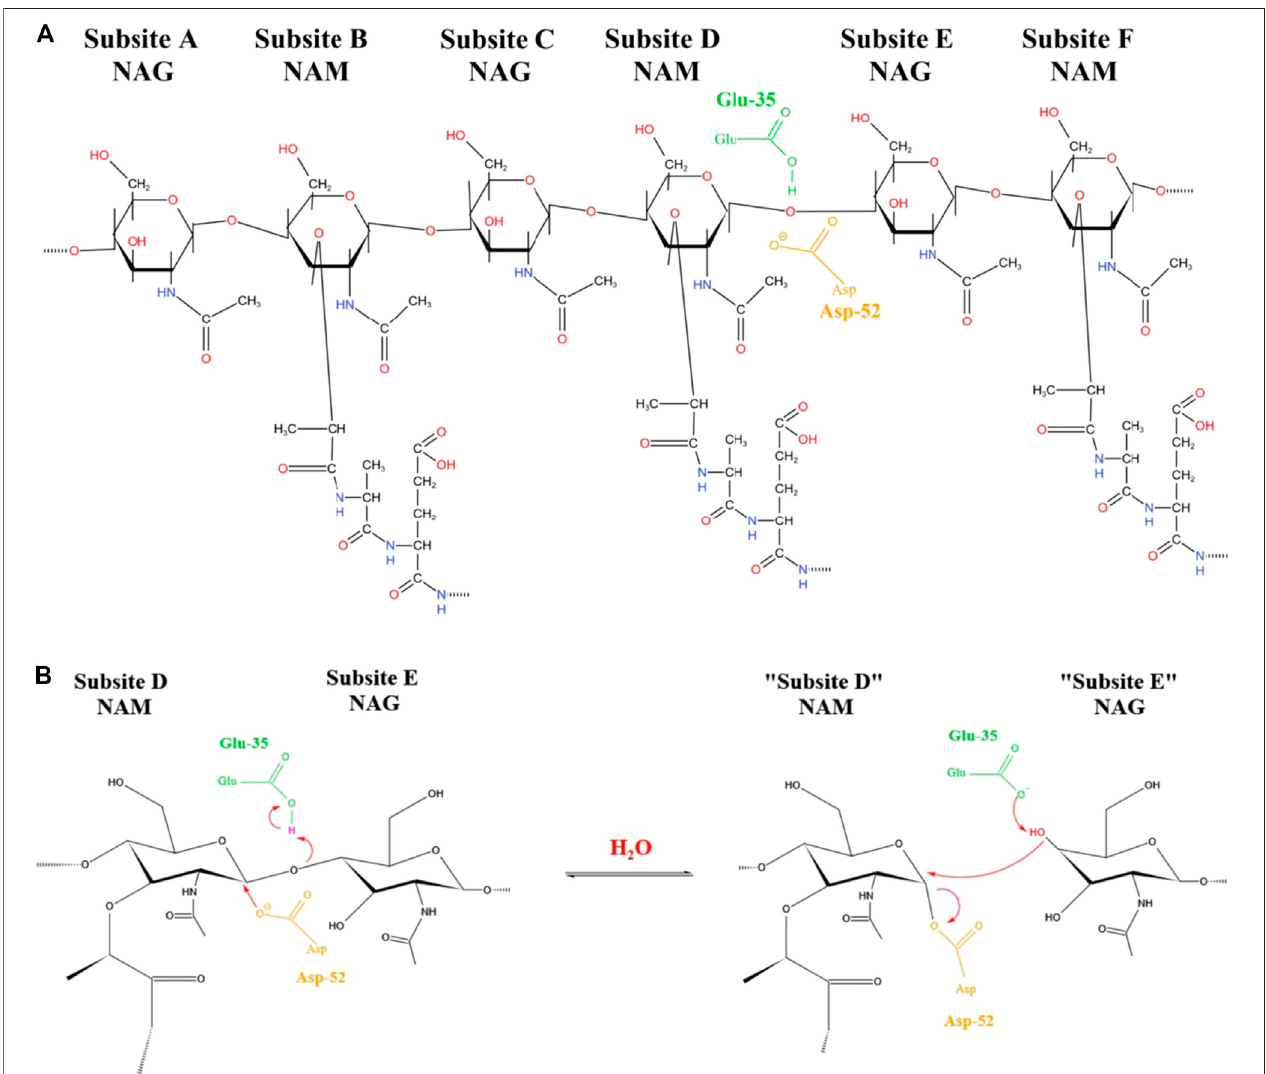
FIGURE 1 | Chemical structure simulation diagram of hydrolysis site of lysozyme . The active site of lysozyme is bound to six continuous sugar monomers through six subsites (A-F), and then hydrolyzed by double substitution reaction β - 1,4 glycosidic bond, the catalytic group acts on the D site (A) . D and E are stretched into a half chair transition state, the catalytic group glutamic acid (Glu) 35 is bound to the D site, and aspartic acid (Asp) 52 is bound to the E site to hydrolyze the peptidoglycan skeleton of bacterial cell wall (B) .